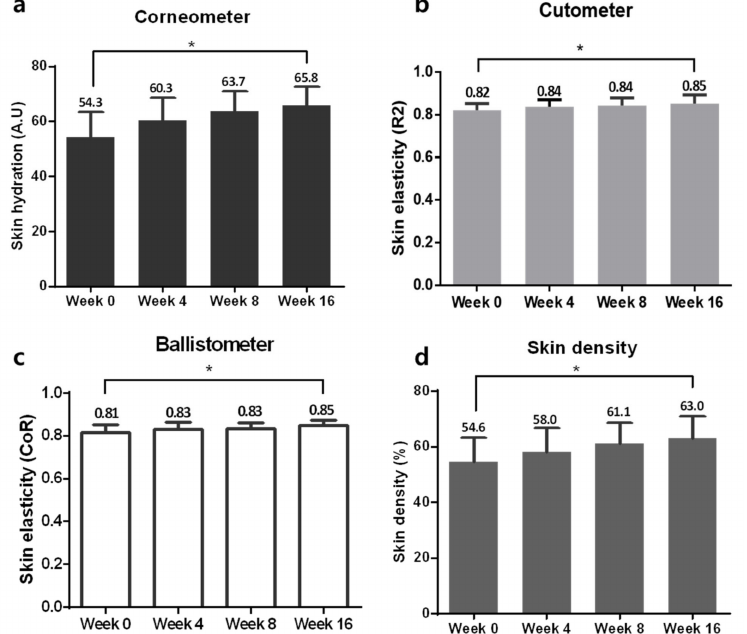
Figure 6. Improvements in neck rejuvenation. ( a ) Changes in skin hydration on a Corneometer. ( b ) Changes in skin elasticity on a Cutometer. ( c ) Changes in skin elasticity on a Ballistometer. ( d ) Changes in skin density on Ultrascan during the study period. * p < 0.05, repeated-measure analysis of variance